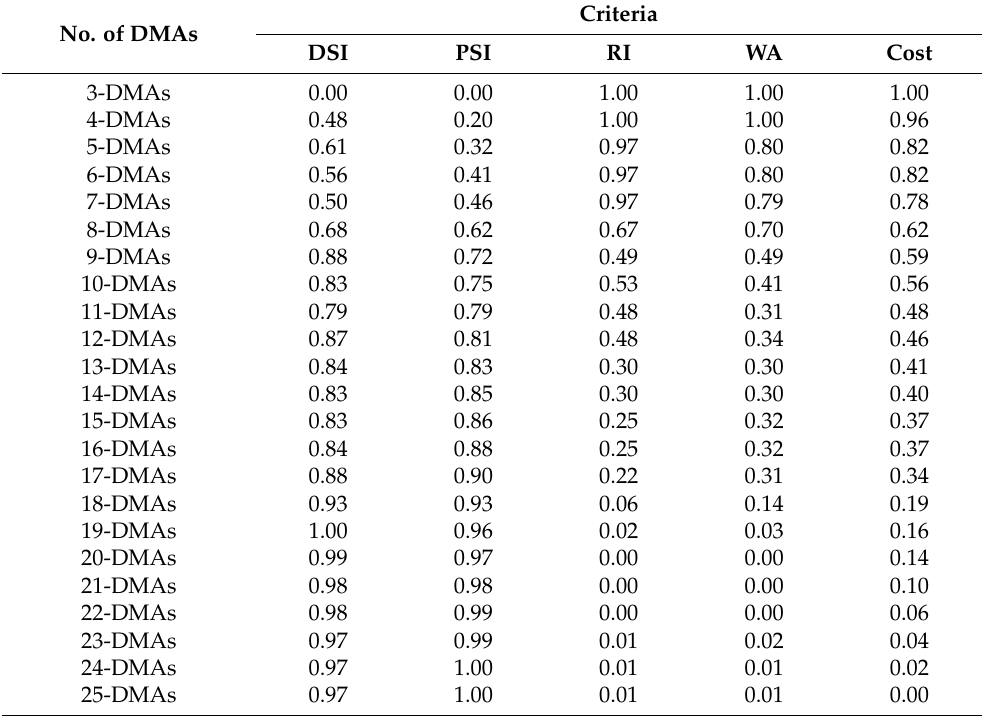
Table 5. Standardization of performance indices for 23 DMA